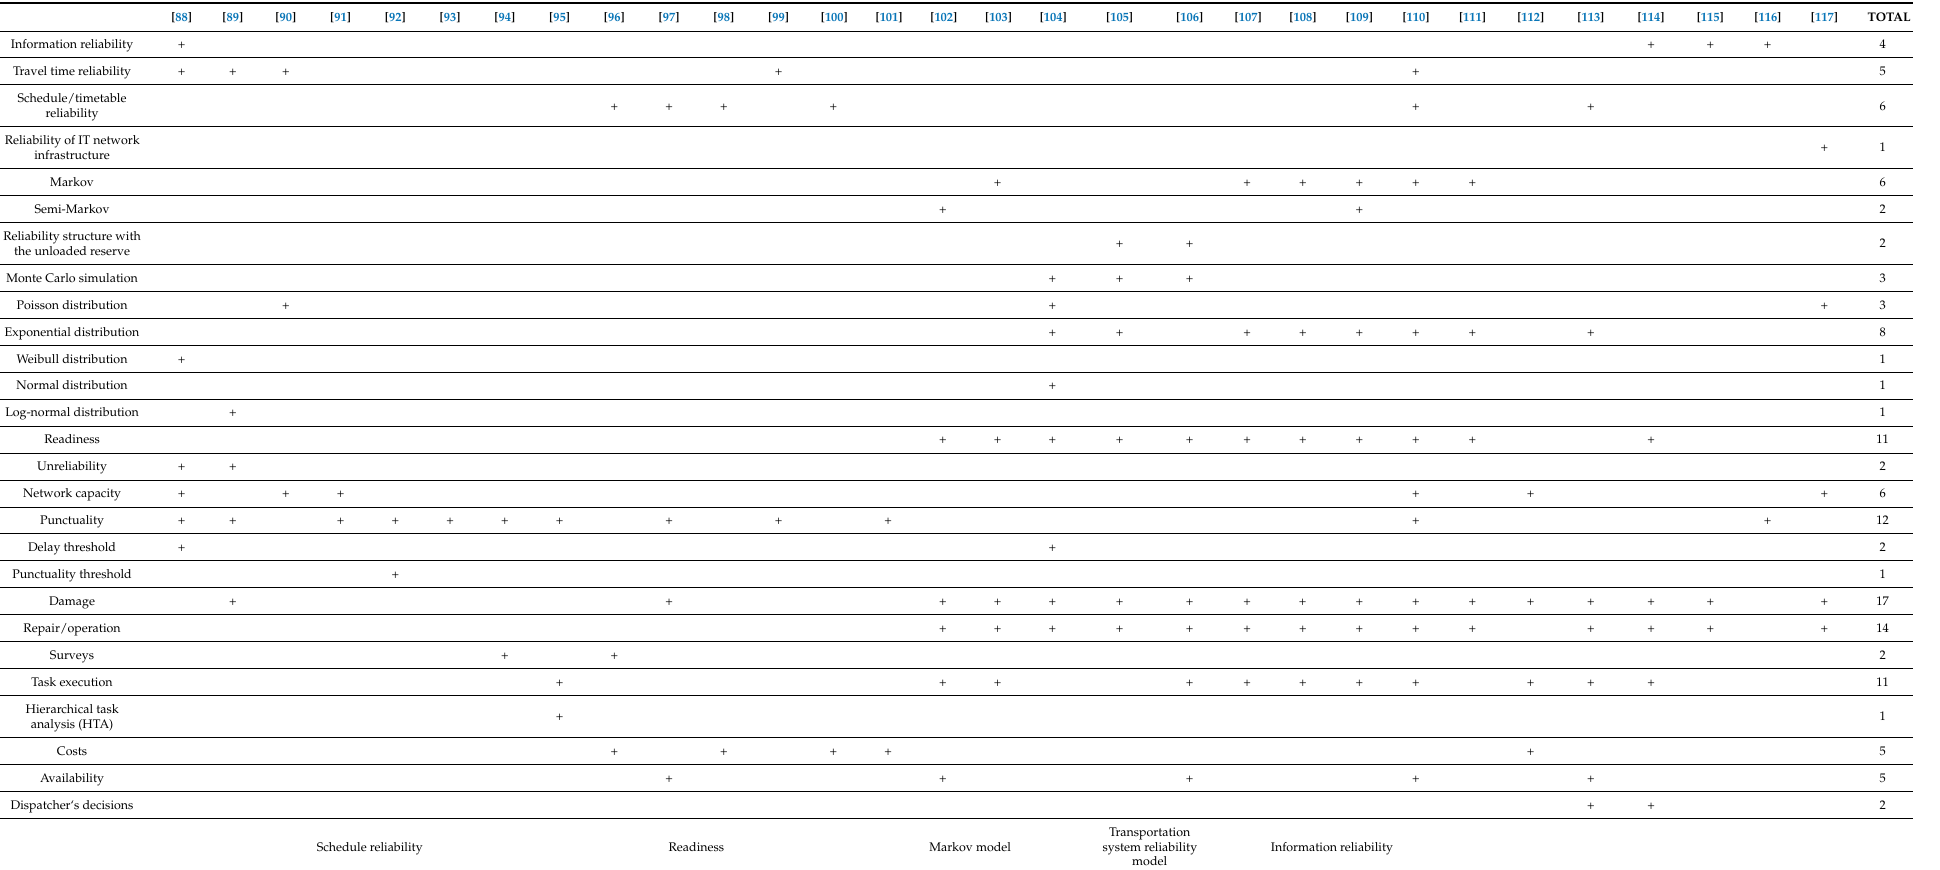
Table A3. Reliability methods and models in transportation systems.